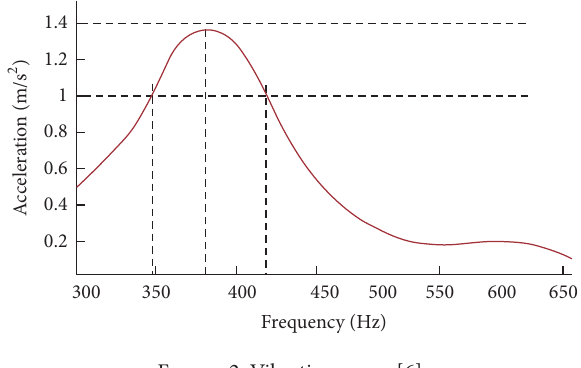
Figure 2: Vibration curve [6].